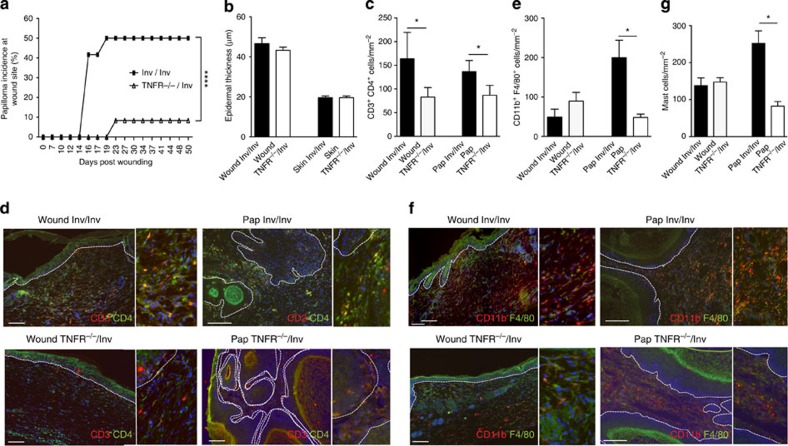
Role of TNFR signalling in wound-induced tumours.(a) Incidence of papillomas in TNFR-1/-2−/− (TNFR−/−/Inv; n=12) and control (Inv/Inv; n=12) BM chimeras (****P<0.0001; Fisher’s exact test). (b) Epidermal thickness in healed and unwounded skin, defined as the distance from basal to upper granular layer and measured at ten sites per mouse (wound Inv/Inv: n=4; wound TNFR−/−/Inv: n=8; skin Inv/Inv: n=8; skin TNFR−/−/Inv: n=10). (c–g) Infiltration of different immune cell populations in wound beds and tumour stroma of post-wounded InvEE and TNFR−/− chimeric skin (*0.01<P<0.05; unpaired t-test). (d,f) Histological sections were stained with antibodies to CD3 (red in d) and CD4 (green in d) or CD11b (red in f) and F4/80 (green in f) and double positive cells were quantified (c,e). Magnified views are represented on the right. (g) Mast cells were quantified following toluidine blue staining. (c,e,g) n≥3 mice per condition and ≥3 fields were quantified per section. Means±s.e.m. are shown. (d,f) Nuclei were stained with 4,6-diamidino-2-phenylindole (blue); dotted lines indicate basement membrane. Scale bars, 300 μm.